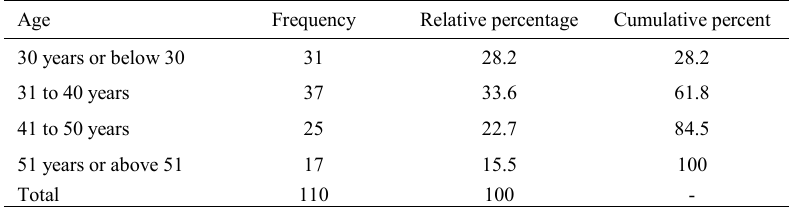
Table 2: Relative distribution of respondents by age